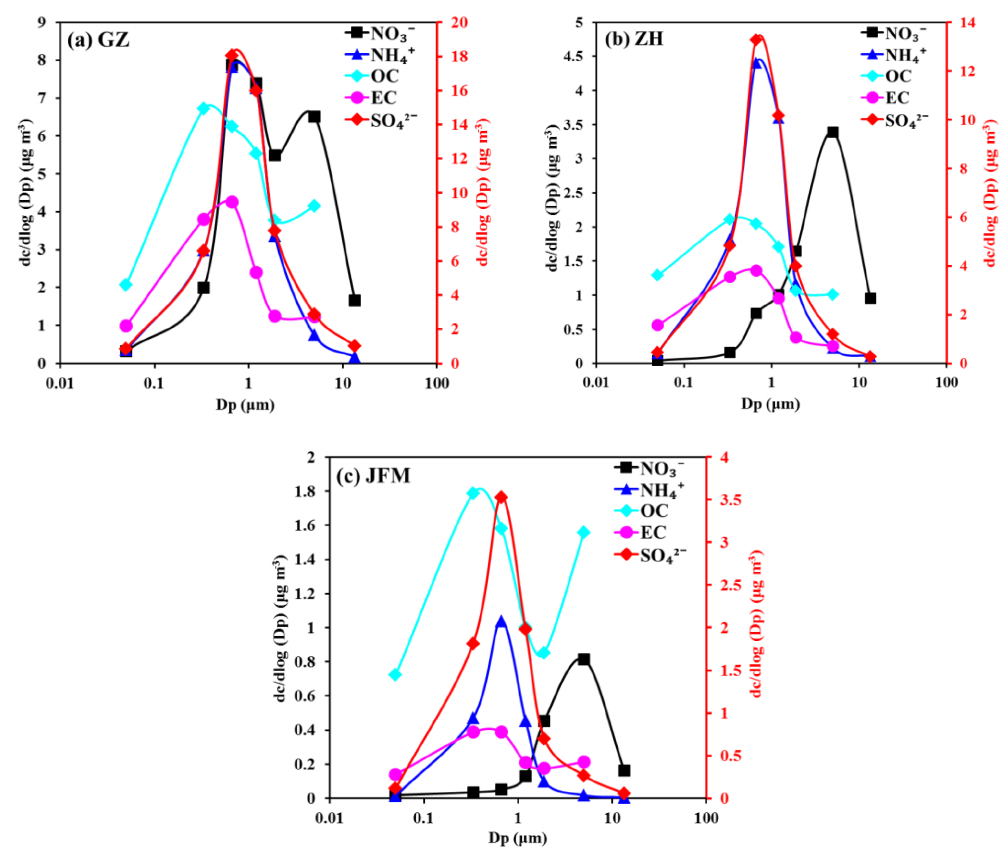
Figure 3. The mass size distribution of major compositions (SO 2 − is plotted against the right y axes).